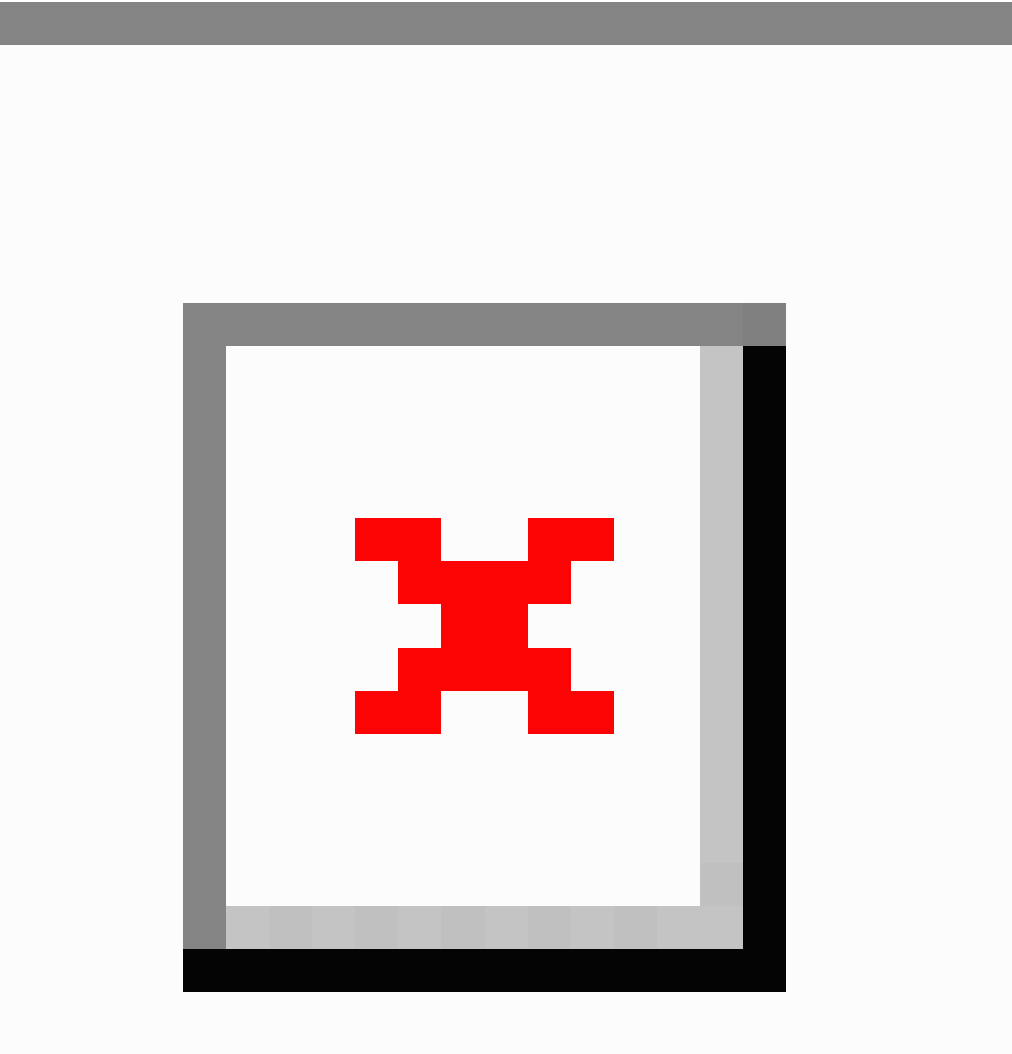
Figure 2. Forest plot for the differences in waist circumference changes between Internet-based interventions and minimal interventions. % Weight: weights assigned to